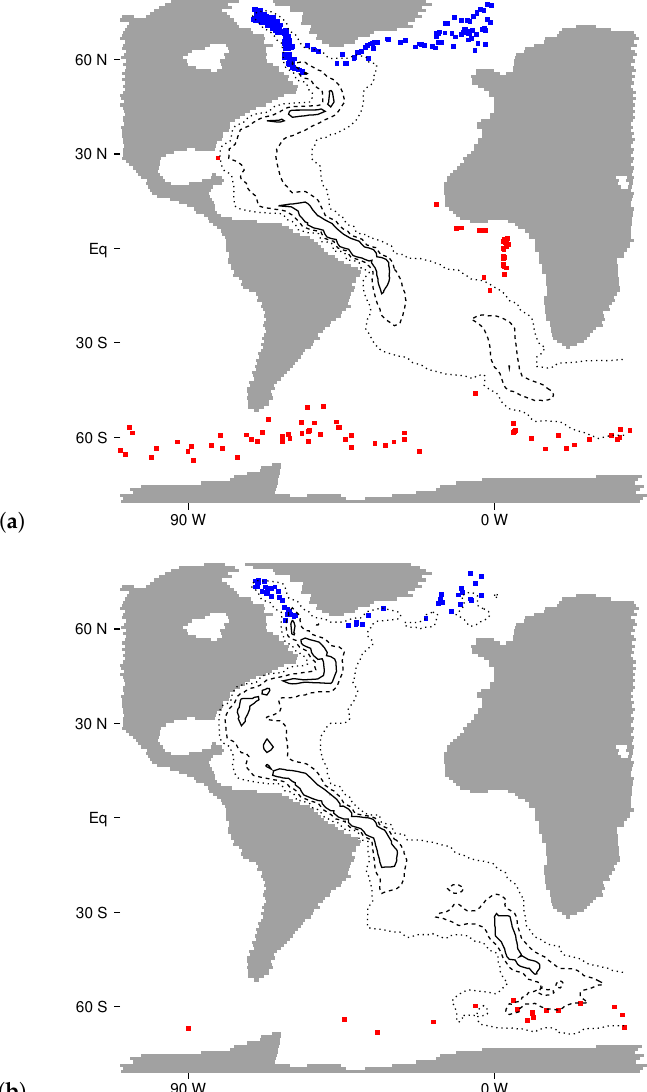
Figure 12. Horizontal pathway to upwelling of North Atlantic Deep Water. ( a ) Simulation with mixing. ( b ) Simulation without mixing. Blue (Red) dots indicated downwelling (upwelling) locations. Contouring indicates the percent of WME pathways that pass through each 3 by 3 degree grid box (10, 30, and 50